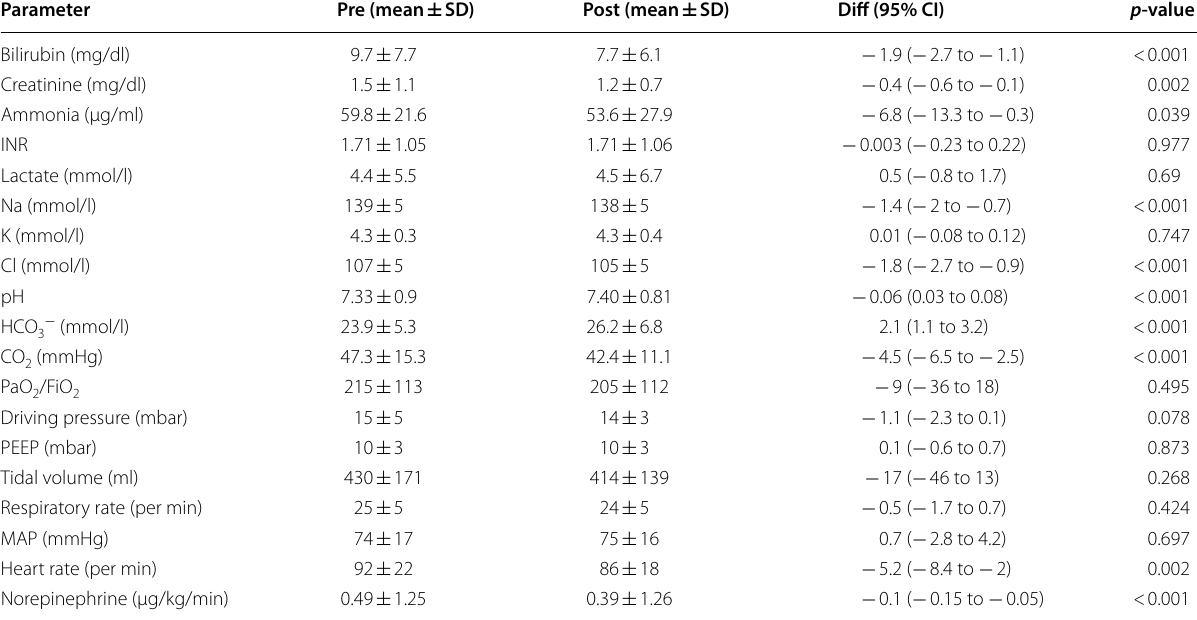
Table 4 Illustrations of the differences of post-therapy minus pre-therapy parameters using a random effects linear regression